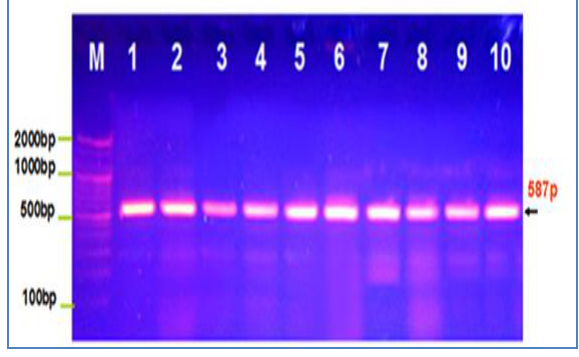
Figure, 2: Agarose gel electrophoresis show the Nested PCR product analysis of 18S rRNA gene in cryptosporidium spp . positive fecal samples. Where M: Marker (2000-100 bp), lane (1-5) positive sheep samples and lane (6-10) positive goat sample (587 bp) PCR product (Second